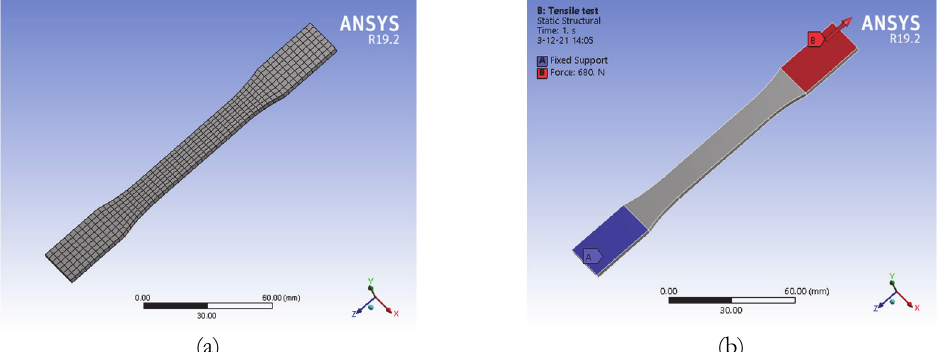
Figure 10: (a) Meshed tensile specimen (b) Tensile specimen with applied boundary conditions.